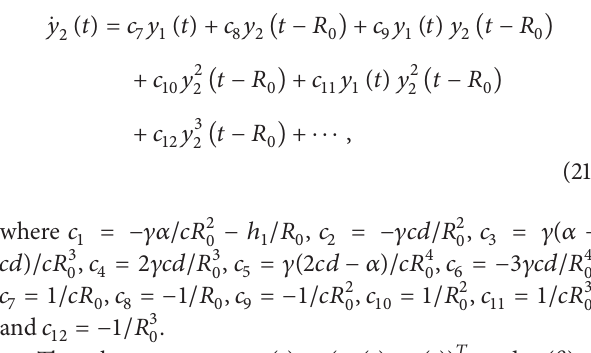
negative real parts. And the transversality condition holds as